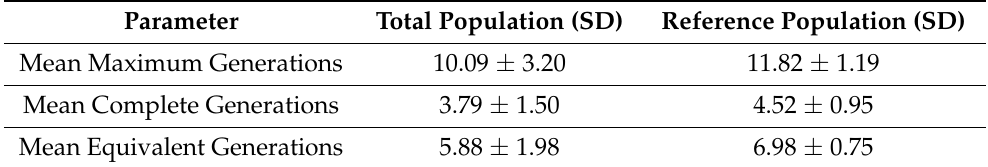
Table 3. Pedigree completeness for the total and the reference